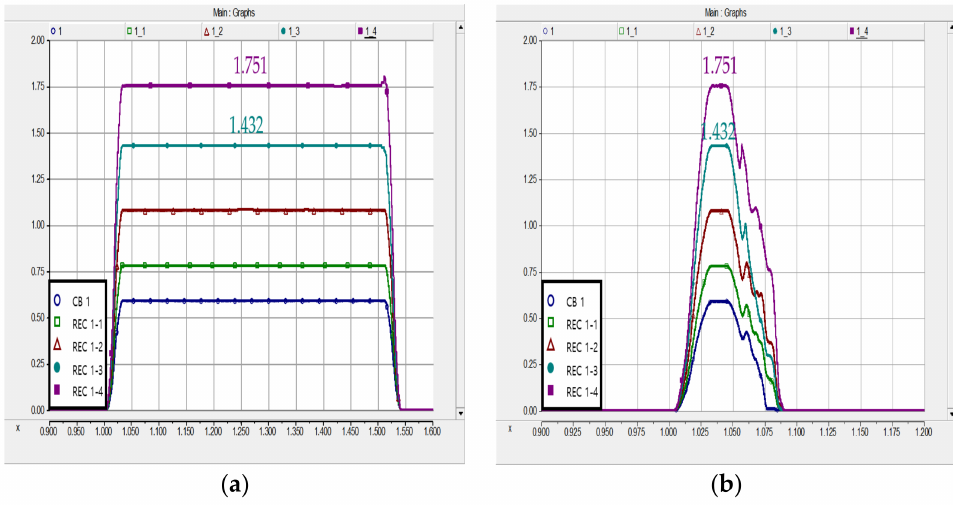
Figure 13. HIF simulation: measured value of feeder 1. ( a ) Before applying algorithm; ( b ) after applying